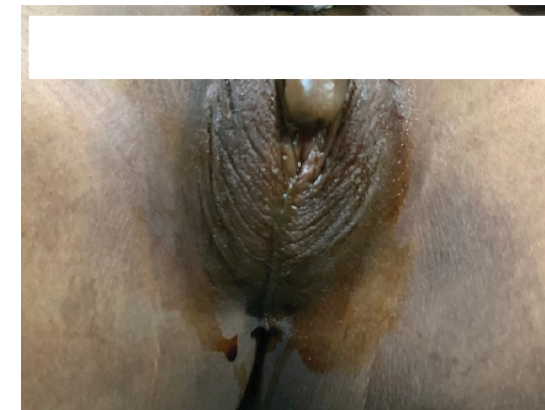
Figure 1B: Phallus, which looks intermediate between a typical clitoris and penis, below which, there is urethral opening. Empty labio-scrotal fold with rugae.